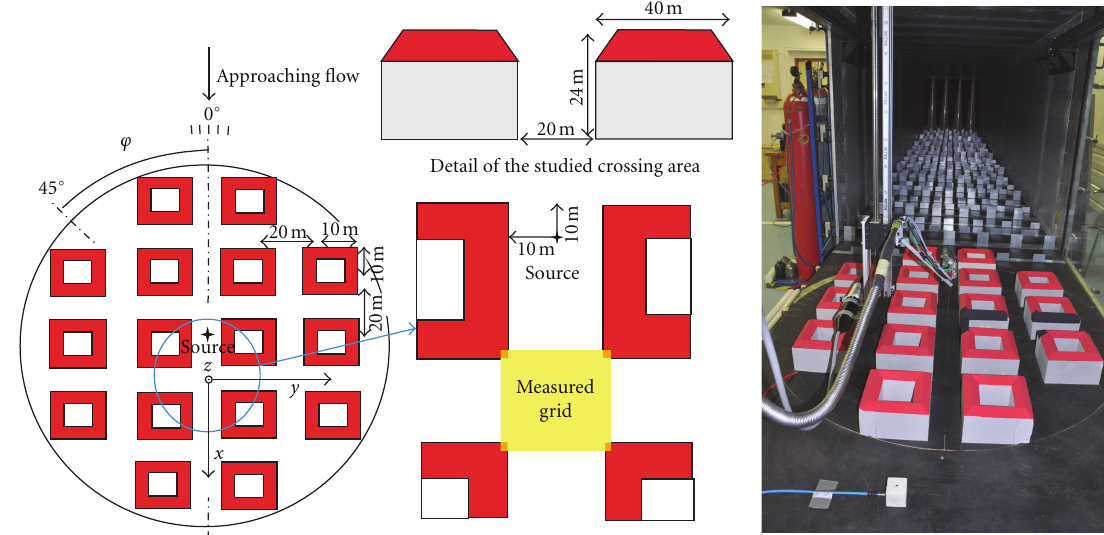
Figure 2: Scheme of the idealized symmetric urban area model (left), the studied X-shaped intersection (middle), and the photograph of the model placed in the wind tunnel (right).